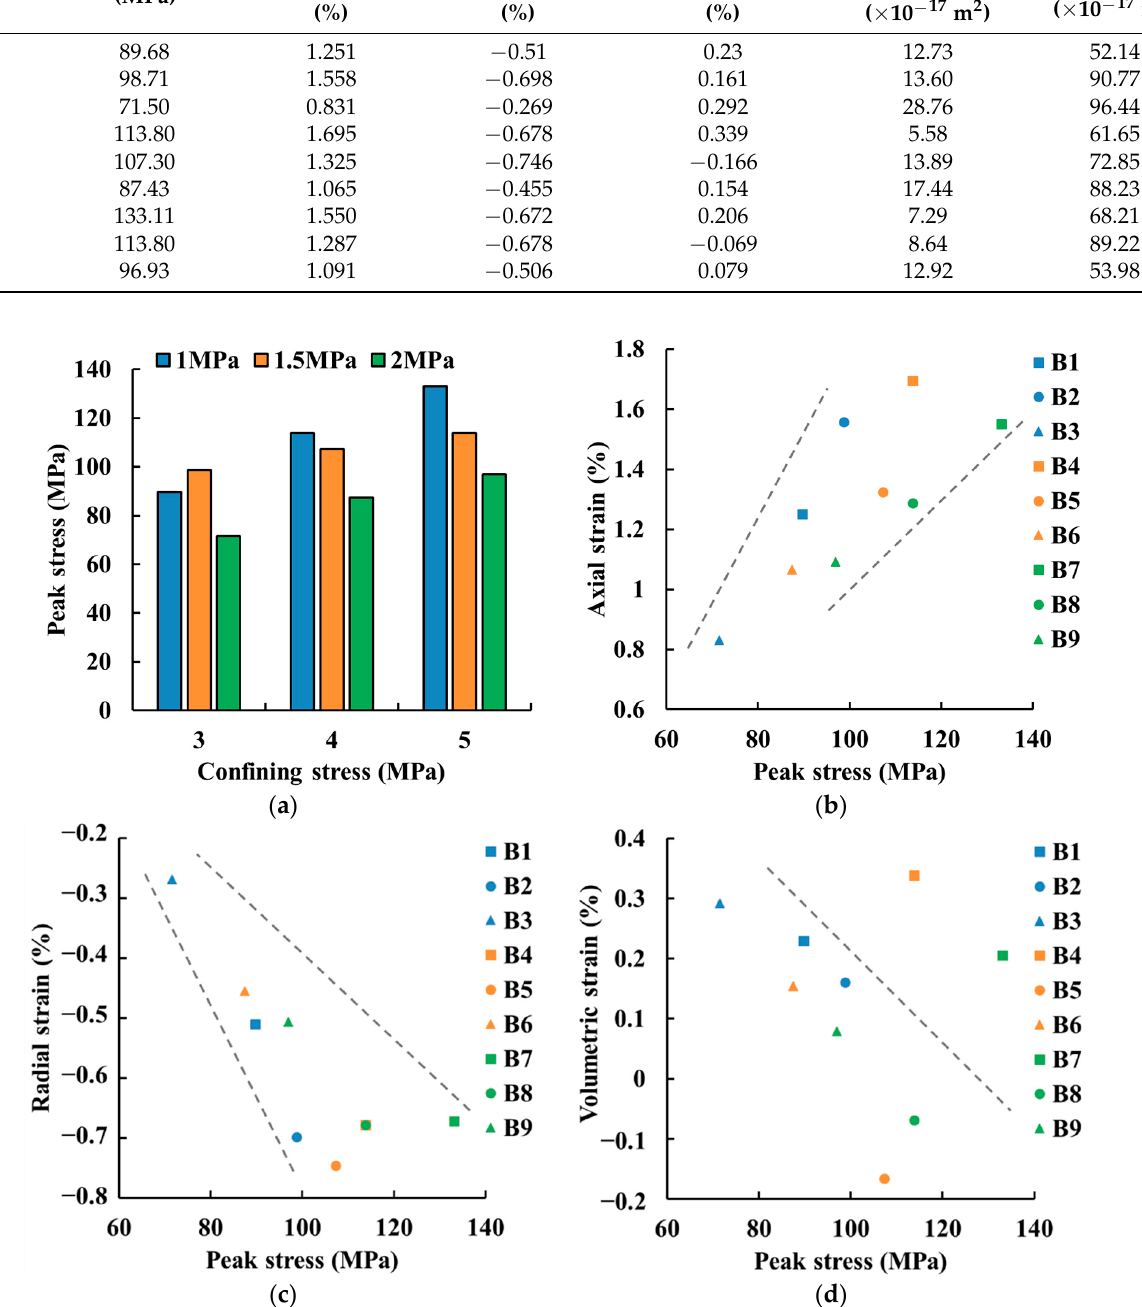
Figure 7. Peak stress and corresponding deformation of sandstone(( a – d ) are the peak strength, corresponding axial, radial, and volumetric strain,